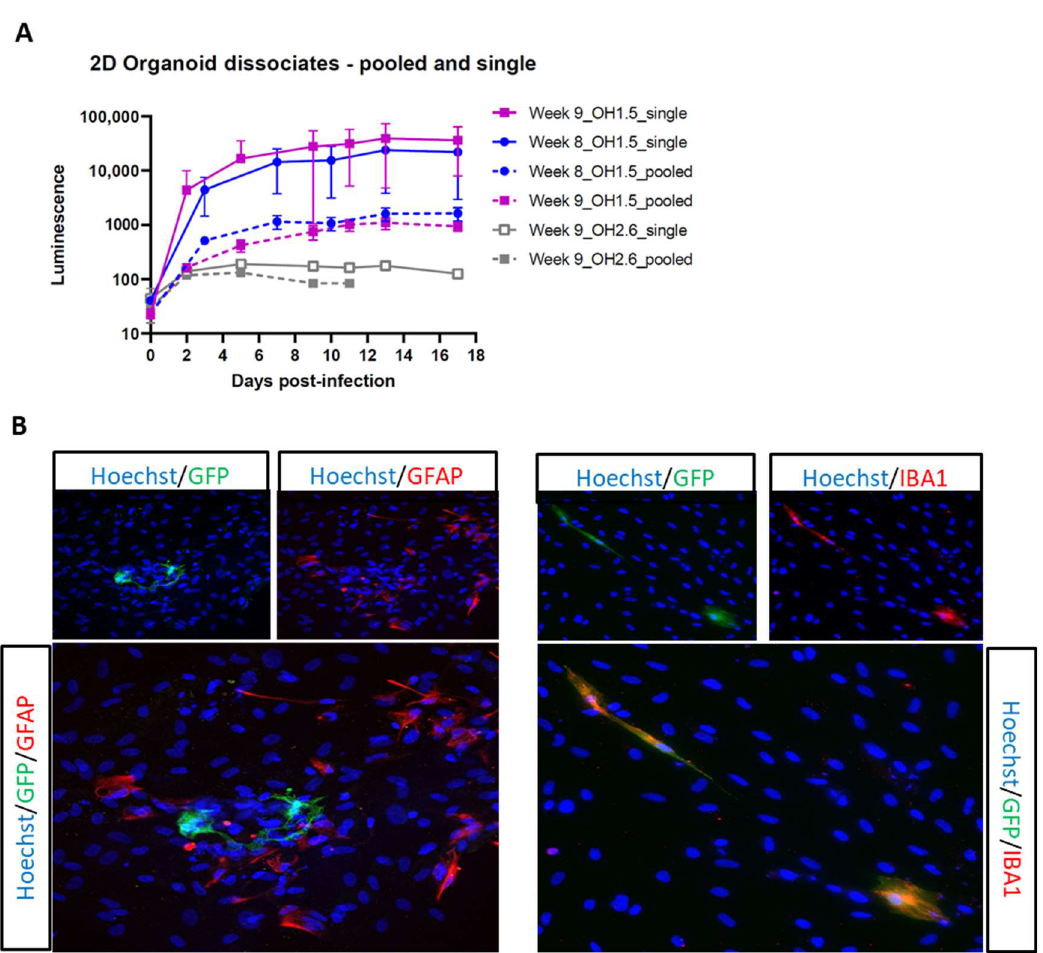
Figure 5. Optimization of 2D organoid dissociates HIV infection. ( A ) 2D organoid dissociates (OH1.5 and OH2.6), dissociated via the pooled and single method, were infected with HIVbal. Supernatant was collected at each timepoint and analyzed for luciferase activity. The means ± standard errors of the means are shown. ( B ) Double immunostainings of GFP combined with GFAP (astrocyte) and IBA1 (microglia) at day 7 post-infection of OH1.5 2D organoid dissociates with HIVbalGFP. All pictures were taken with a magnification of 20 ×.